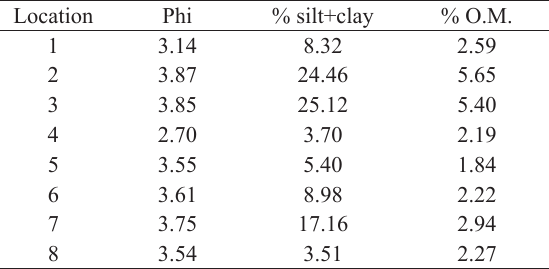
Number of individuals of Xiphopenaeus kroyeri in total, juvenile, adult male, adult female with rudimentary ovaries (RU) and reproductive females (MA) collected from May 2008 through April 2009, and from May 2009 through April 2010, with t and